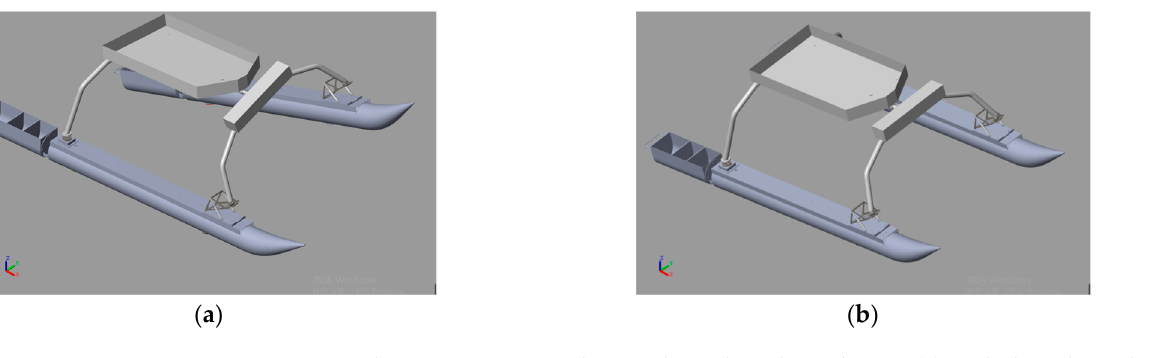
Figure 16. Simulation animation with or without the spherical joint. ( a ) With the spherical joint; ( b ) Without the spherical joint.